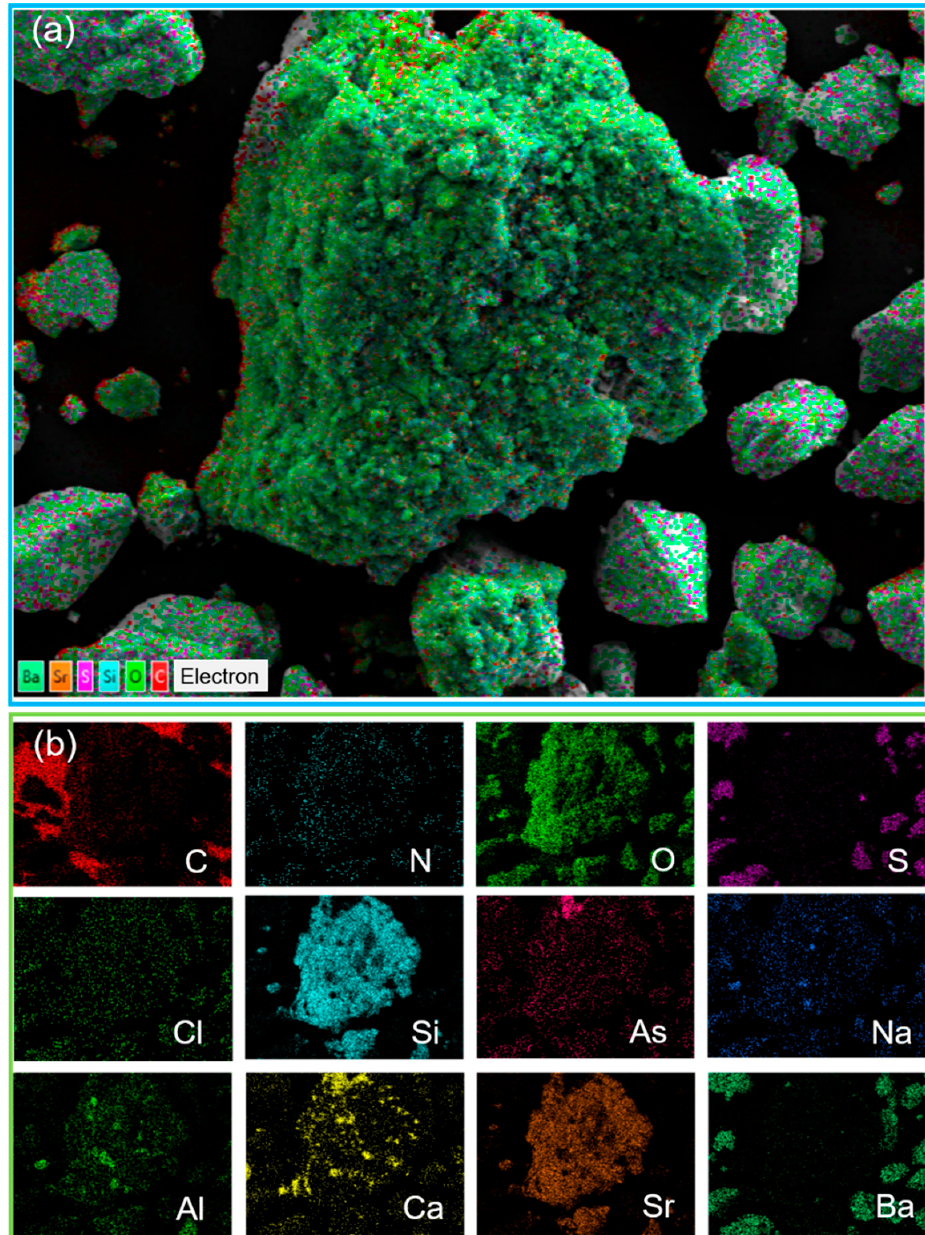
Figure 10. EDS profile ( a ) and elemental mappings ( b ) involved in the surface of shale gas OBDCs after treatment by using CO2 SHSs.